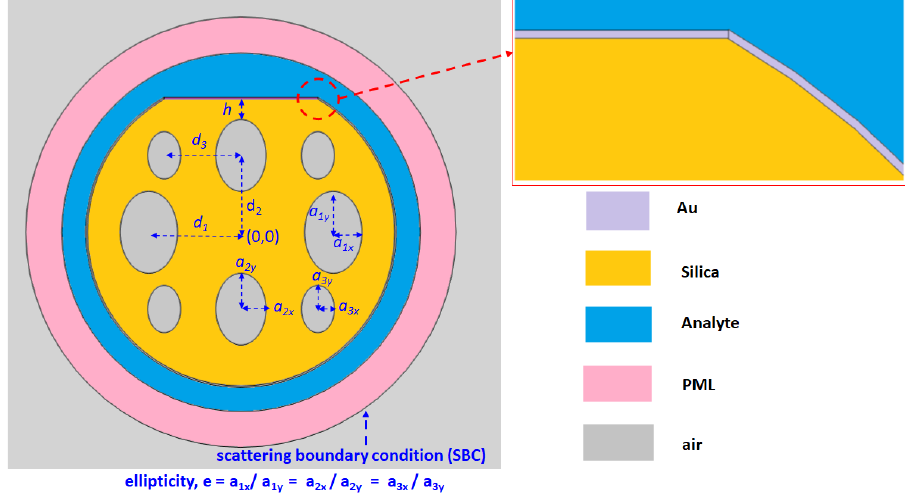
Figure 1. Cross-section of the designed SPR-PCF sensor with structural parameters.